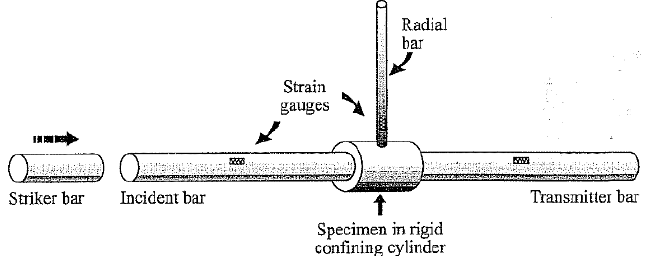
Figure 26. Diagram of the three-dimensional SHPB test stand (reprinted from Ref. [90]). The equipment in the 3D configuration consists of: two axial measuring bars (initiating bar and transmitting bar), which allow one to measure the forces and displacements of the measuring bars axially in the X direction, and an additional one in the 3D radial bar configuration in the Y direction, which allows one to perform a radial stress measurement during the experiment. The main advantage of the 3D configuration was indicated—it enables the measurement and obtaining a comprehensive three-dimensional soil reaction to the dynamic impact. The dynamic response is more extensive compared to the classic 1D SHPB configuration. Publications [91,92] show another advantage of the 3D configuration as the widespread use of this variant of the experiment to measure the shear strength of a soil sample. It is possible to determine the dynamic characteristics of the soil response to HSR. An example of research on the dynamic behavior of sand samples (in conditions without drainage) was used to determine the influence of strain rate in the stress–strain relation. The main result shows an additional advantage of this configuration and indicates that the dynamic response of the soil sample as a stress–strain relation is more sensitive to the adopted pressure value in the test and not very sensitive to the level of loading rates. The final results in the 3D configuration may be the basis for the development of a constitutive model of this soil as a result of taking into account the triaxial stress state. Publication [93] shows a diagram of a triaxial Hopkinson bar test stand (Figure 27). The equipment is a research system that allows one to perform dynamic experiments in the uniaxial, biaxial and triaxial variants. It is worth noting that the bars are used as three pairs of test bars in three perpendicular directions X, Y and Z. In the X direction, a set of measuring bars (initiating and transmitting) in the 1D configuration is normally located. In addition, there are bars in the Y and Z directions—at their ends, there are load cylinders that limit the pressure in the bars. Figure 28 presents a schematic process of wave propagation: (a) a standard for 1D configuration is provided: ε I —initiating wave, ε R —reflected wave, ε T —transmitting wave; and (b) additional for 3D configuration: ε y 1 and ε y 2 —confining